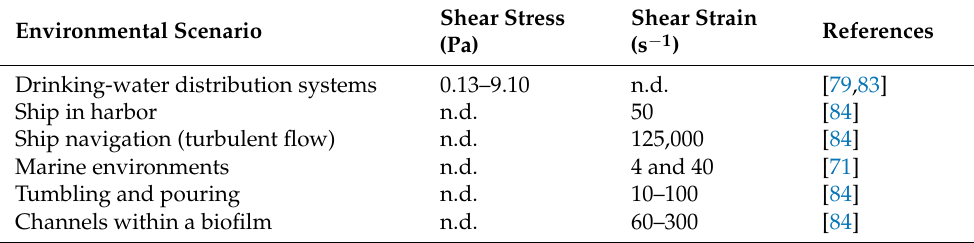
Table 2. Environmental scenarios and their typical shear